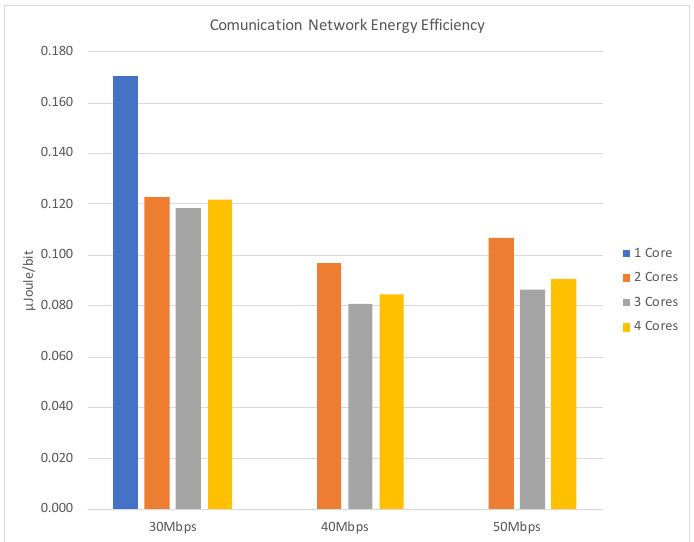
Figure 11. Communication network energy efficiency for different multicore